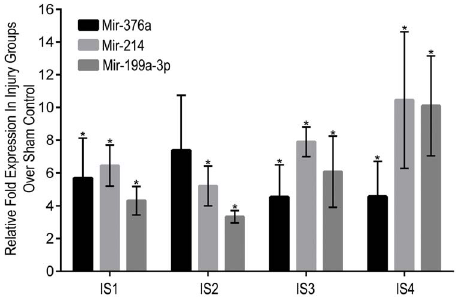
Figure 7. Expression of miRNAs in individual real time PCR assay. The fold upregulation of three miRNAs, miR-376a, miR-214 and miR-199a-3p, in the injury groups over the sham mice was validated using the individual real time PCR assays. Similar to the miRNA arrays, expression of the three miRNAs was found to be up regulated in the injured groups over the sham animals. Data presented is the fold up regulation ( 6 SEM; * P , 0.05) calculated from the mean DDCt value obtained from three biological samples for each injury group. Statistical significance was calculated using the individual Ct values obtained from the three biological replicates for each injury